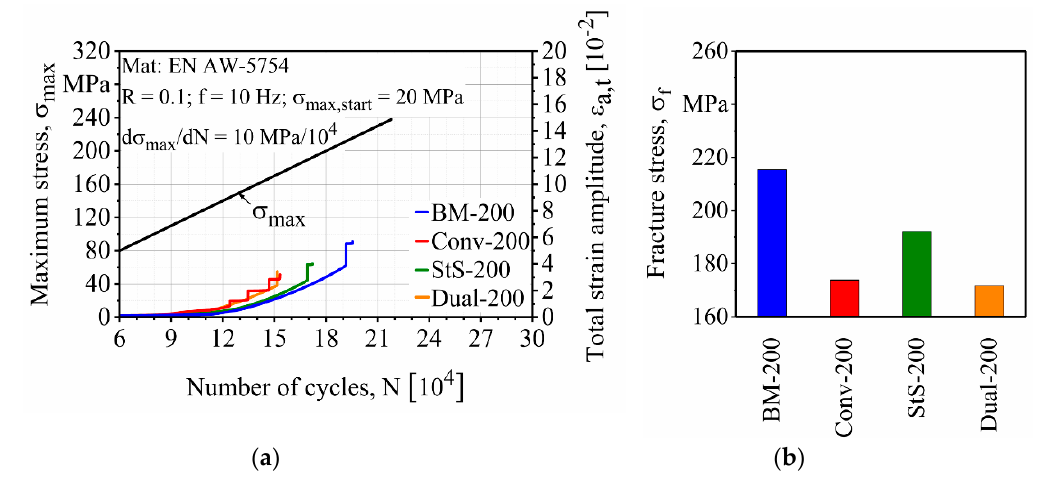
Figure 20. Effect of the salt spray test on the ( a ) load increase test and ( b ) fracture stresses of base and friction stir welded (FSW) EN AW-5754 specimens.